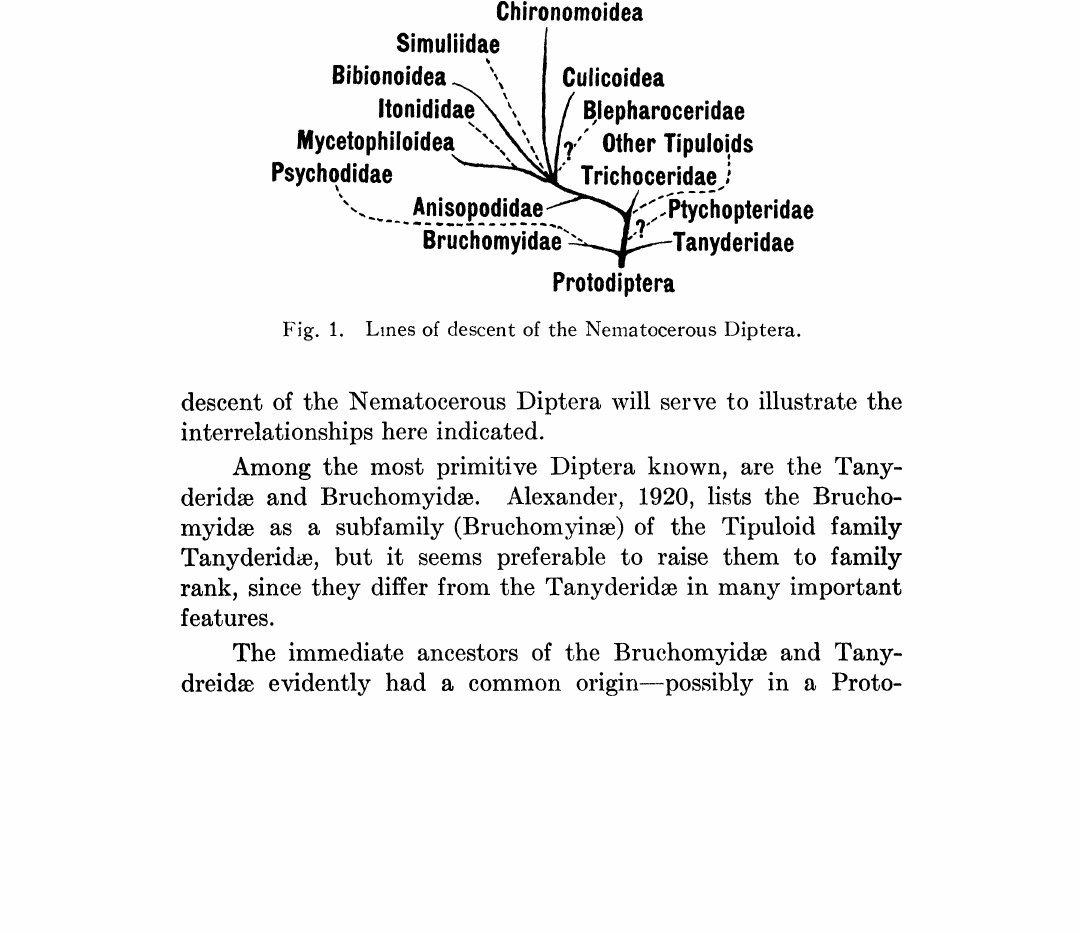
Fig. 1. Lines of descent of the Nematocerous